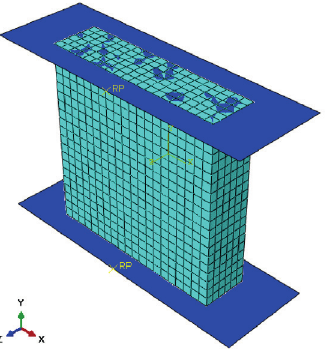
Fig. 1. Finite element model of the uniaxial compression test